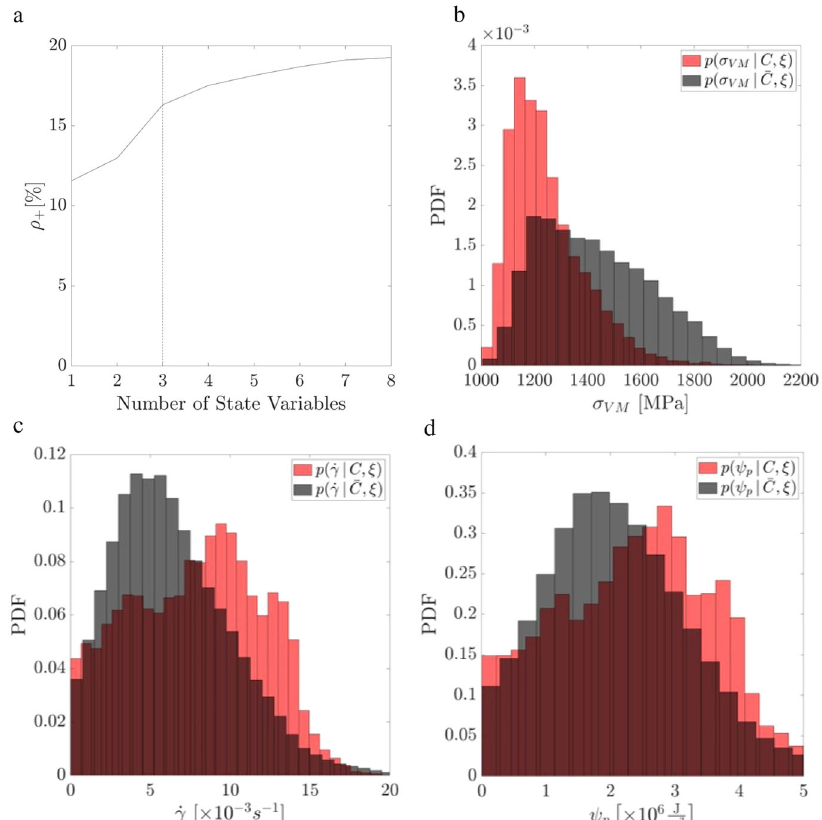
Fig. 3 Most predictive state variables for crack nucleation locations. a Increasing geometric mean probability of prediction for known cracked material volumes with incremental addition of state variables into the posterior PDF; Cracked and uncracked marginal likelihood distributions for b the von Mises stress σ VM , c the maximum plastic slip-rate _ γ , and d the plastic defect energy ψ p